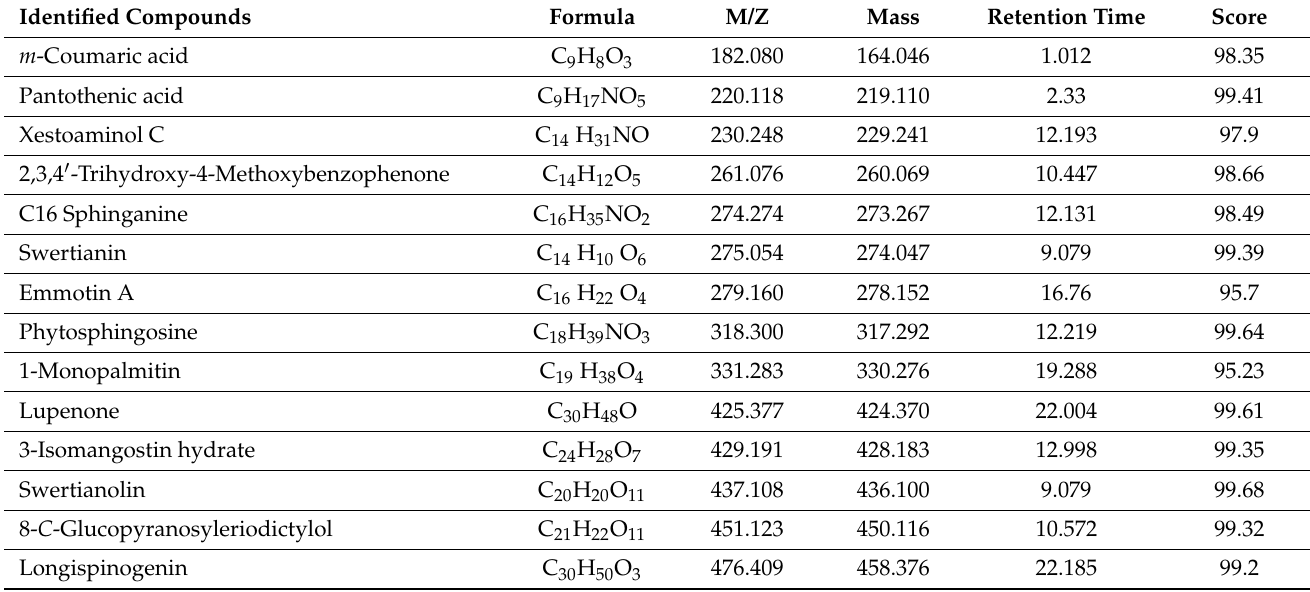
Table 3. Bioactive compounds identified by Q-ToF-LCMS.